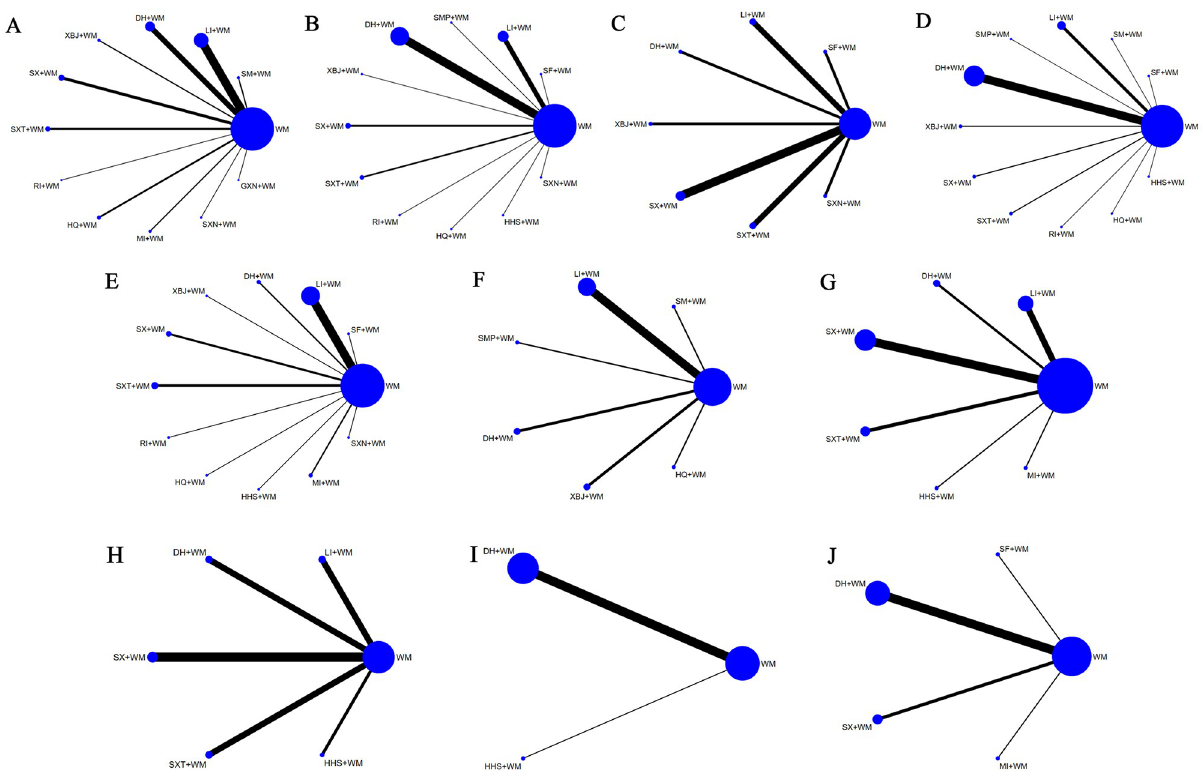
Fig 2. Network relationship diagram of each outcome index of CMIs combined with WM in the treatment of IPF. Note: A , CER; B , PaO2; C , PaCO2; D , DLCO; E , FVC; F , TLC; G , FEV1%; H , FEV1/FVC%; I , IIIC; and J , TGF.